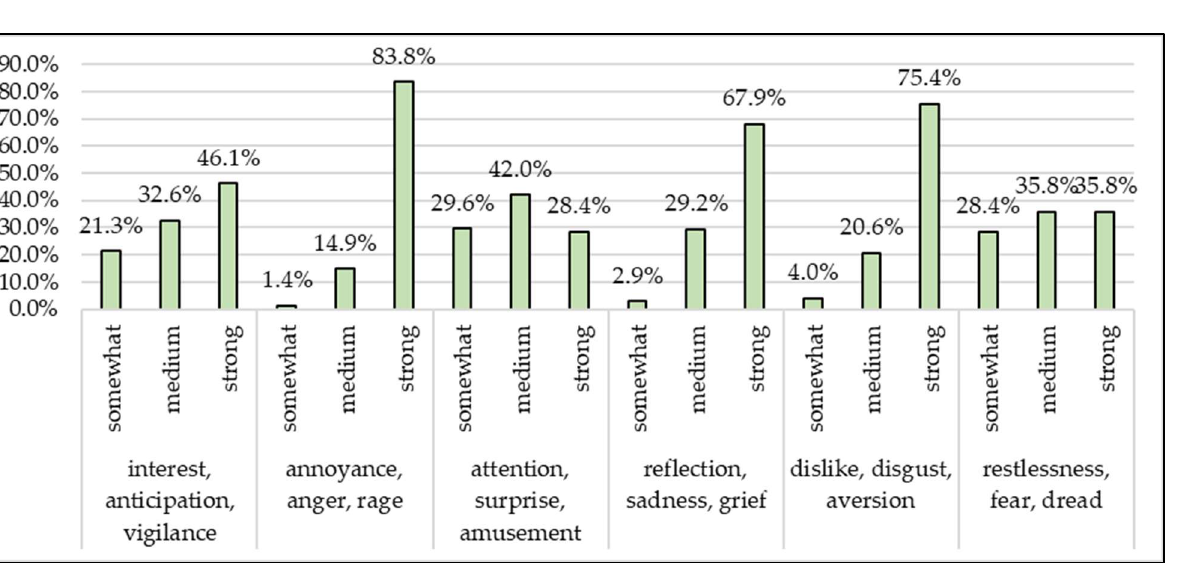
Table 1. Crimes associated with the felony of animal cruelty ( n = 99).